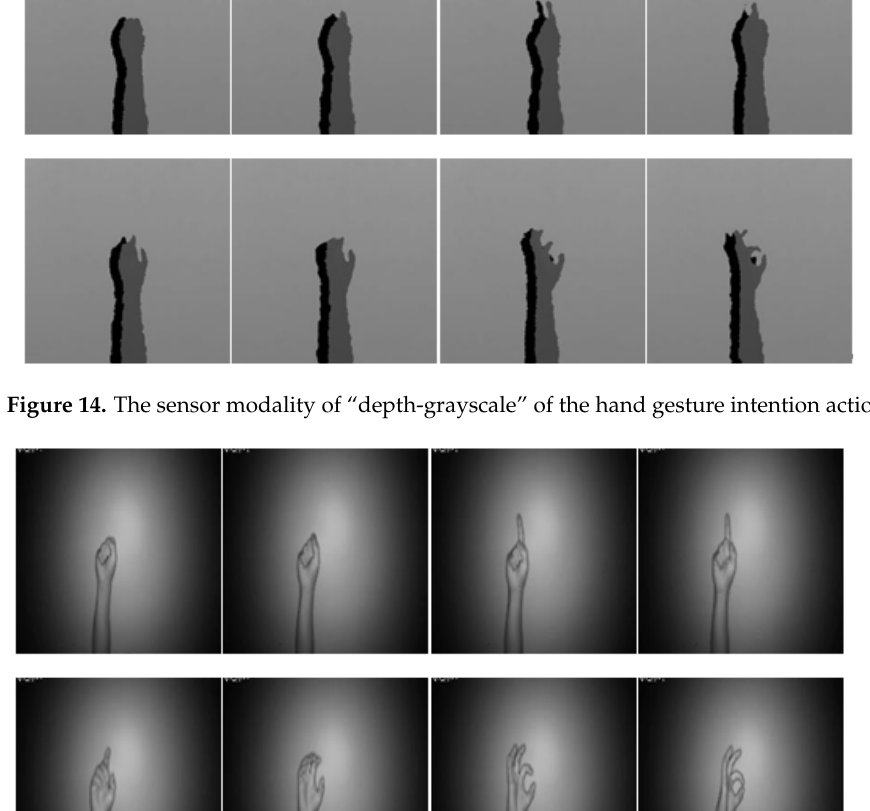
Sensors 2022 , 22 , x FOR PEER REVIEW